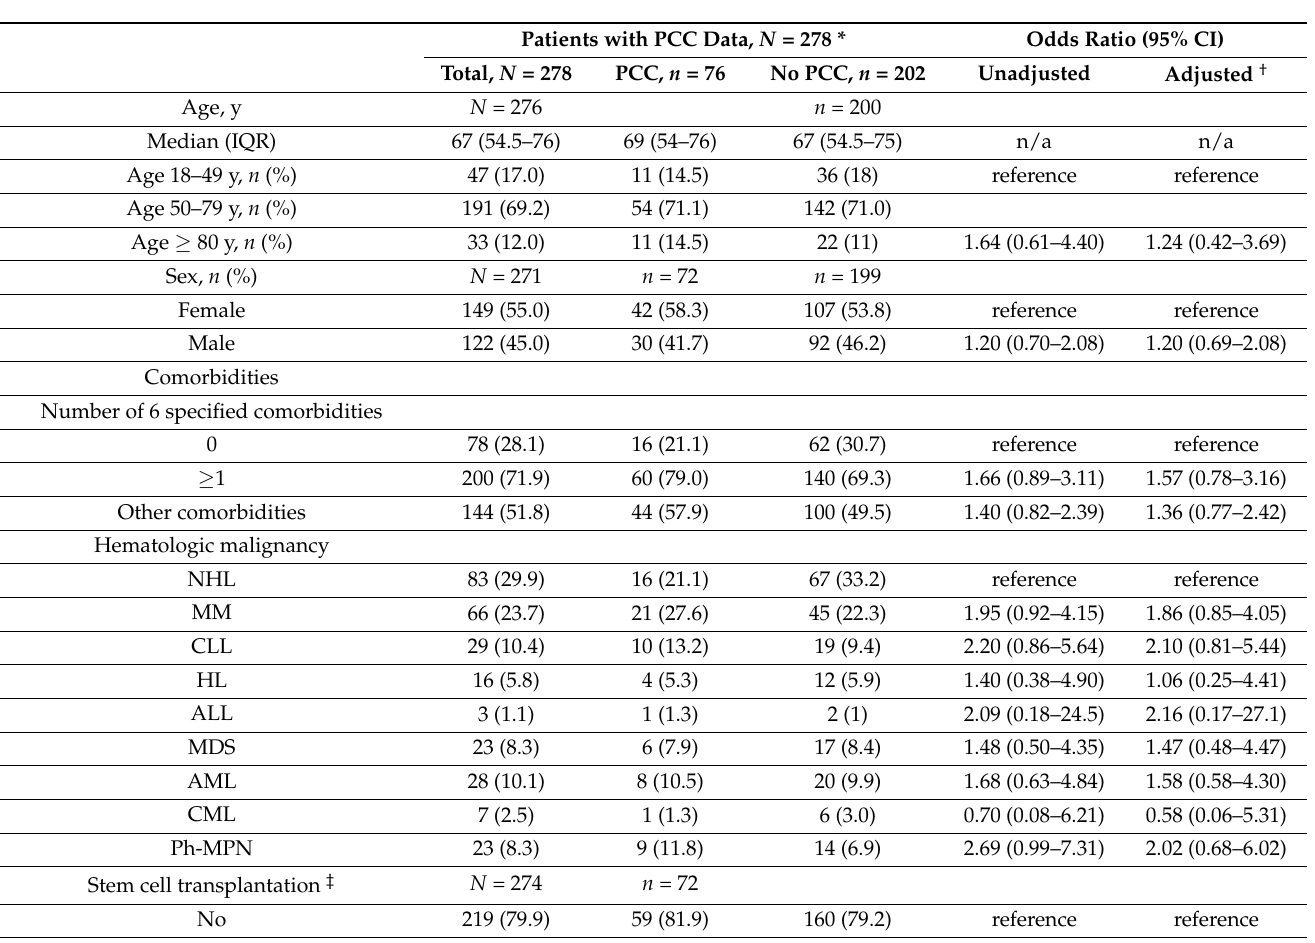
Table 5. Post COVID-19 condition in patients with hematologic malignancies, by patient characteris- tics, hematologic malignancy and COVID-19